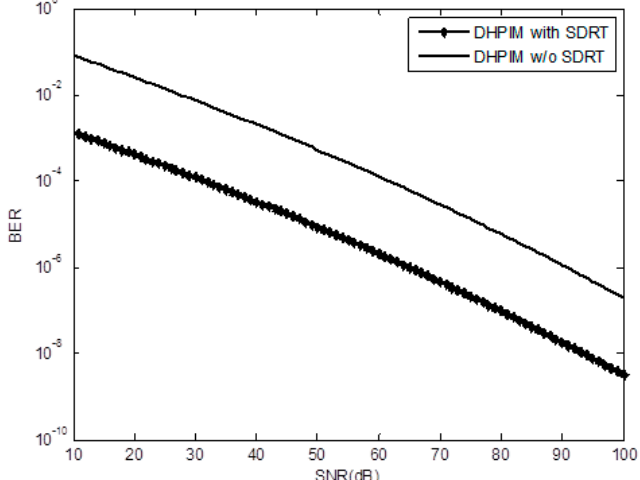
Figure 12. BER performance of DH-PIM with SDRT and without SDRT in a strong turbulence channel.